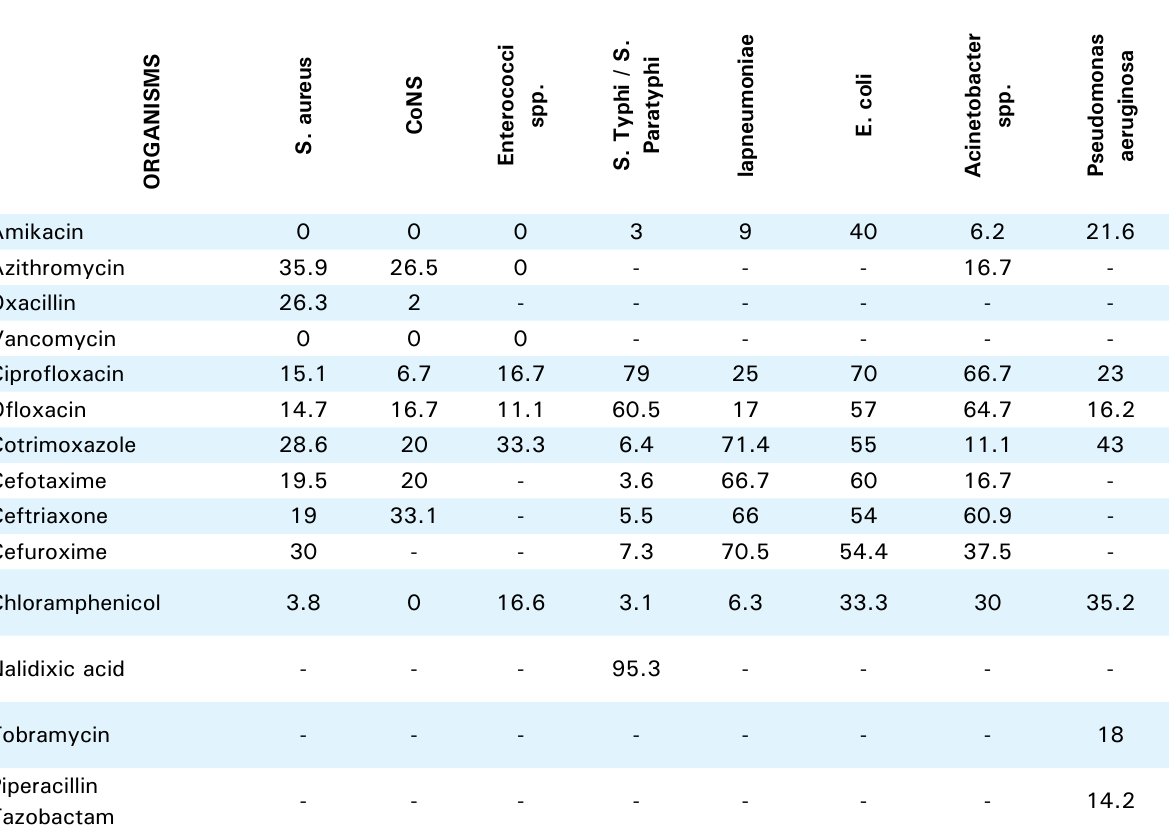
table 2. Percentage of antimicrobial resistance patterns of common blood culture isolates .